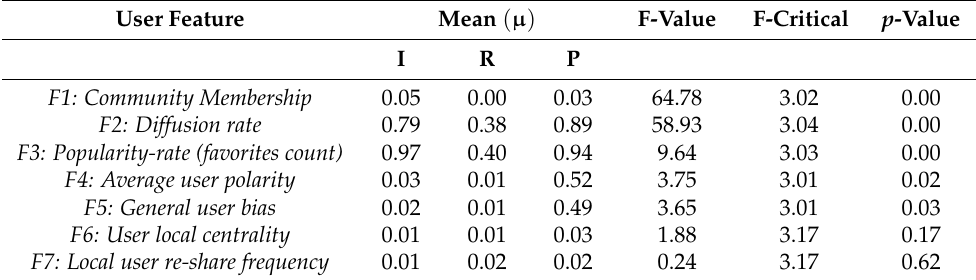
Table 4. ANOVA test results for user features over behavior